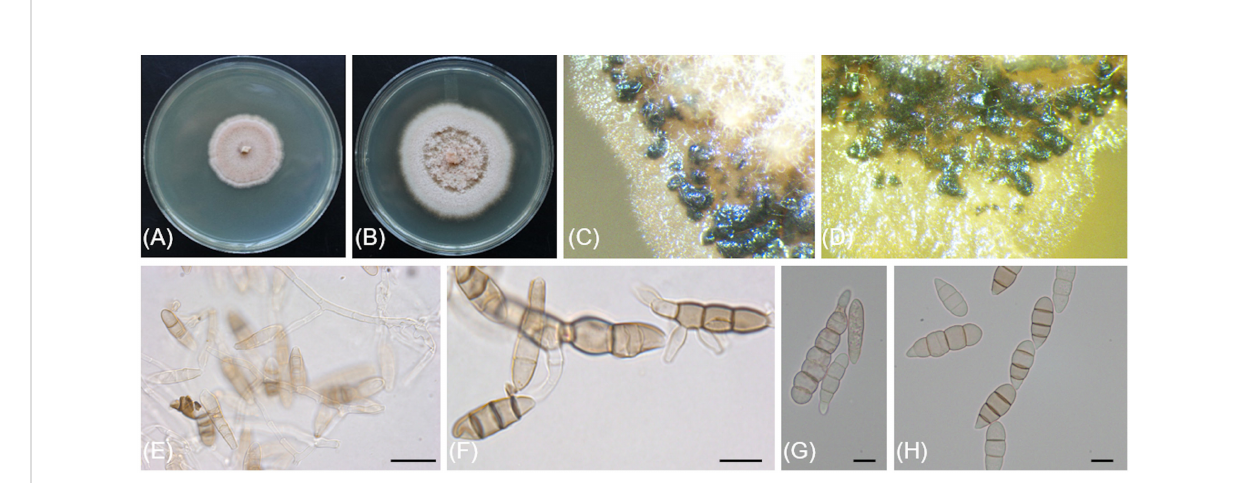
FIGURE 7 Sporocadus incarnatus (CBS 149301/Bent716). (A, B) 14-day-old colonies on MEA and PDA media, respectively. (C, D) . Conidiomata on PDA. (E) Conidiophores, conidiogenous cells and conidia. (F) Germinating conidia. (G, H) Conidia. Scale bars: 20µm (E) ; 10µm (F – H)